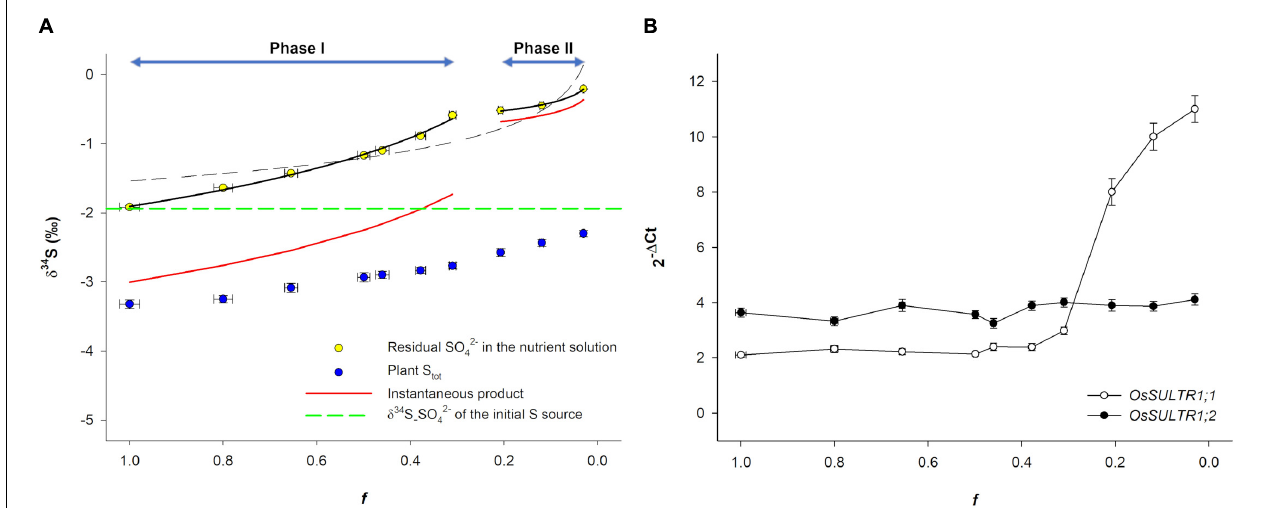
FIGURE 2 | Sulfur isotope dynamic in the closed system and transcriptional analysis of OsSULTR1;1 and OsSULTR1;2 . (A) S isotope dynamic as a function of the fraction ( f ) of SO 42 − remaining in the hydroponic solution. Black dashed line is the Rayleigh curve calculated over the entire f interval, while the black continuous lines are the Rayleigh curves calculated over the two phases: Phase I (1 ≤ f ≤ 0.31) and Phase II ( f ≤ 0.21). Red continuous lines describe the trajectory of the calculated instantaneous product (S ist ) over the two phases. The dashed green line indicates the δ 34 S_SO 42 − value of the initial S source. (B) Changes in the relative transcript levels of OsSULTR1;1 and OsSULTR1;2 in the roots. The numbers in brackets refer to the concentration of residual SO 42 − (expressed as µ M) in the hydroponic solution corresponding to each f value. Data are means ± SE of three independent experiments run in duplicate ( n = 3).